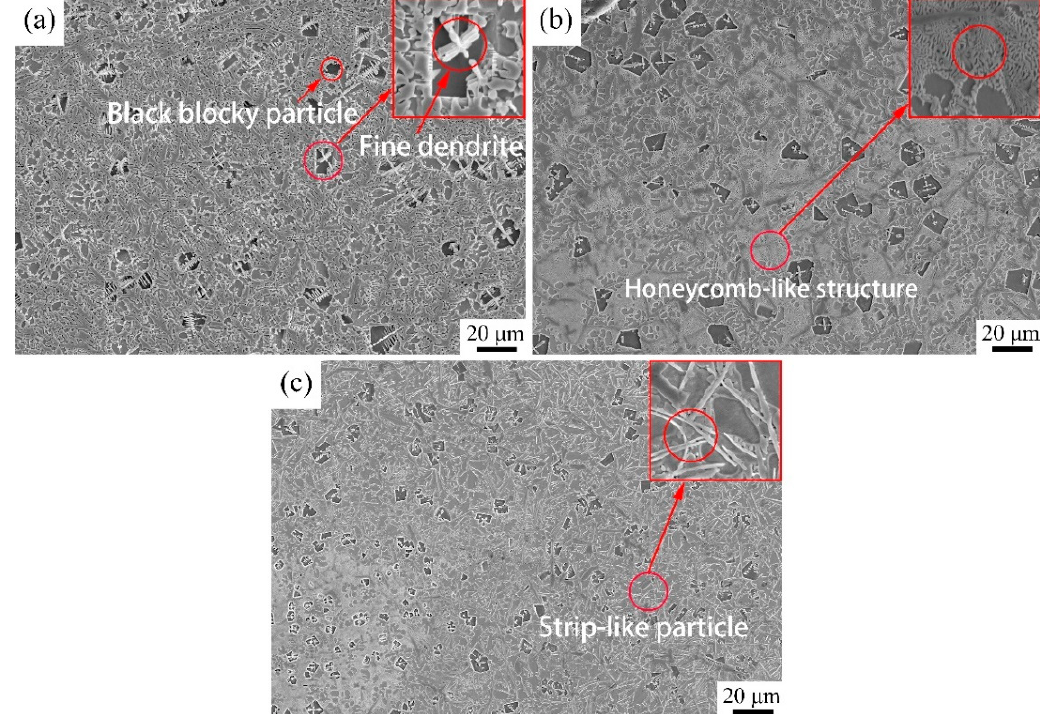
Figure 4. Microstructure of the coatings: ( a ) Coating 1 for 5 mm ∙ s − 1 ; ( b ) Coating 2 for 11 mm ∙ s − 1 ; ( c ) Coating 3 for 17 mm ∙ s − 1 .